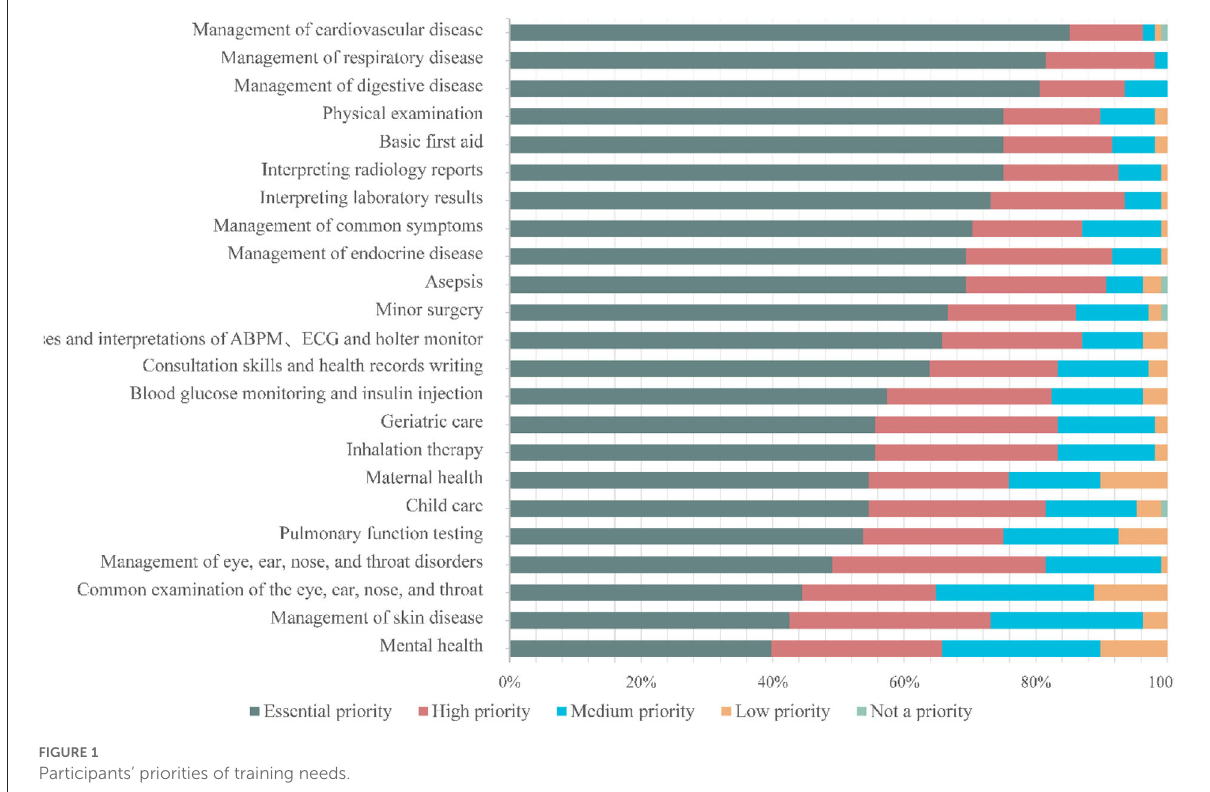
FIGURE1 Participants’ priorities of training